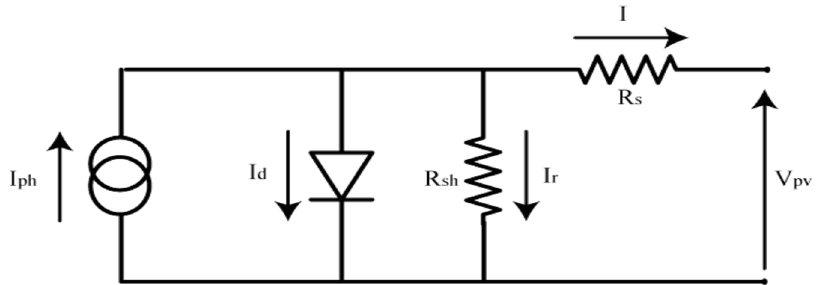
Figure 3. Photovoltaic system.